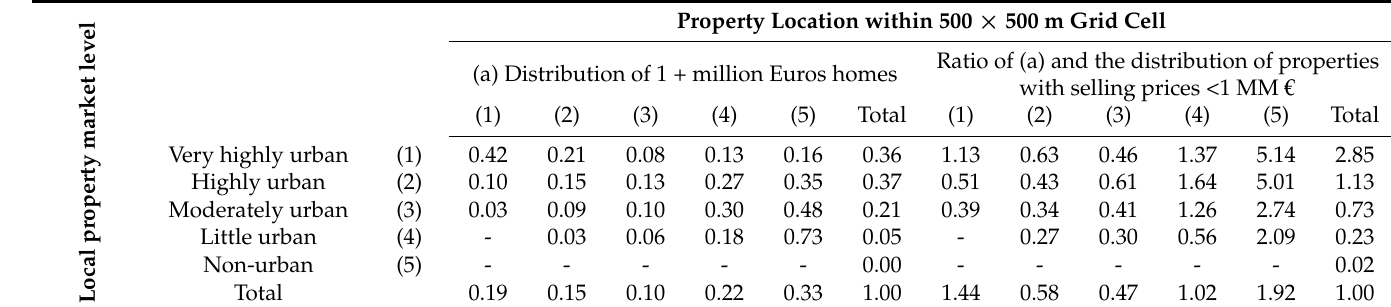
Table 2. Distribution of properties across degrees of urbanization. i